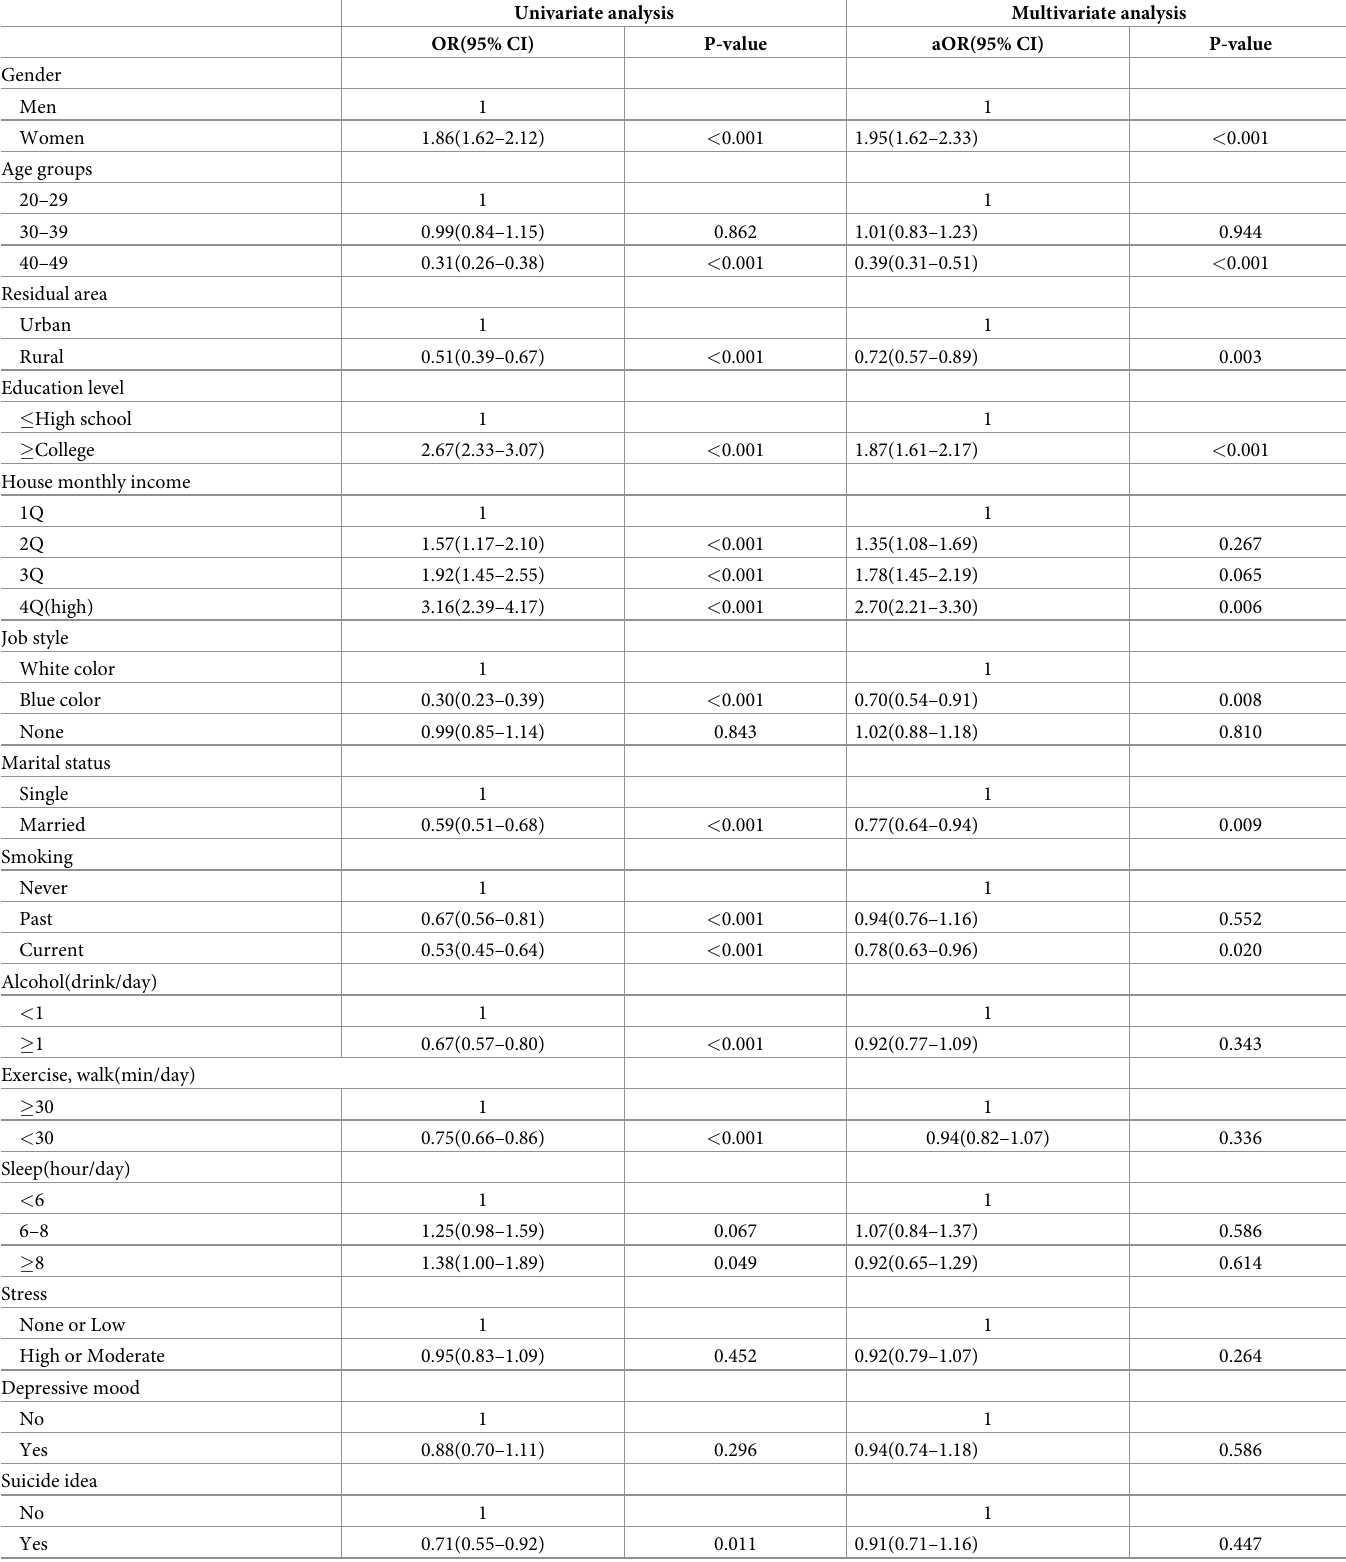
Table 2. Adjusted odds ratio of refractory surgeries among adult in South Korean